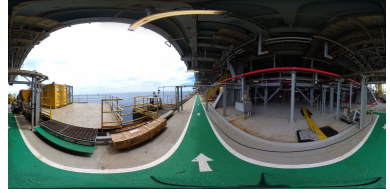
Figure 4. Example of an equirectangular projection